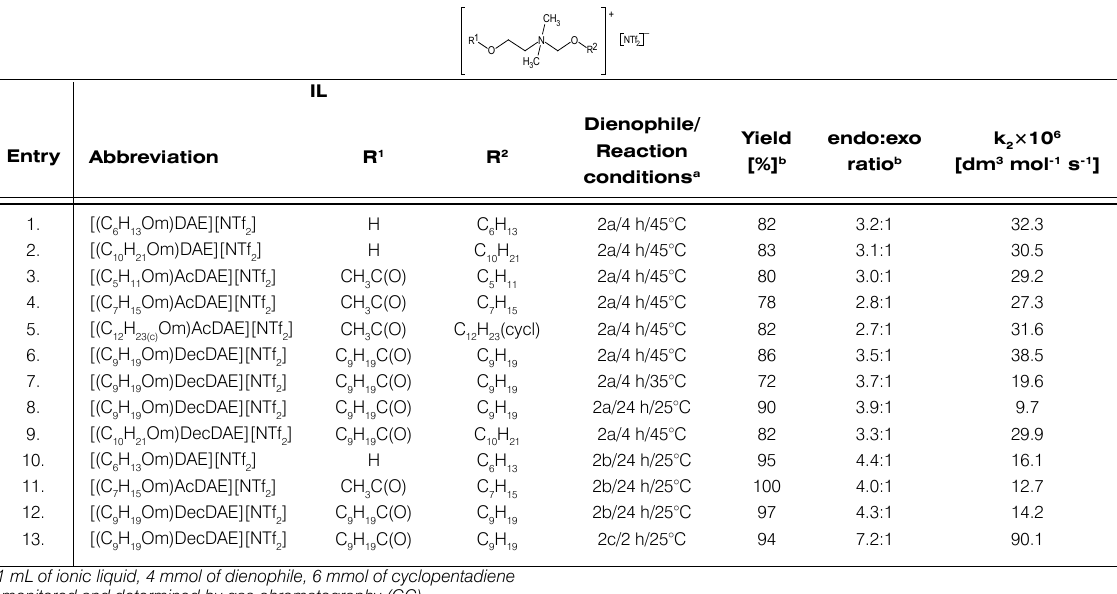
Table 1. The yields, stereoselectivities, and reaction rate constants of the Diels-Alder cycloaddition between cyclopentadiene and dienophiles (2a÷c) in ionic liquids prepared based on deanol.